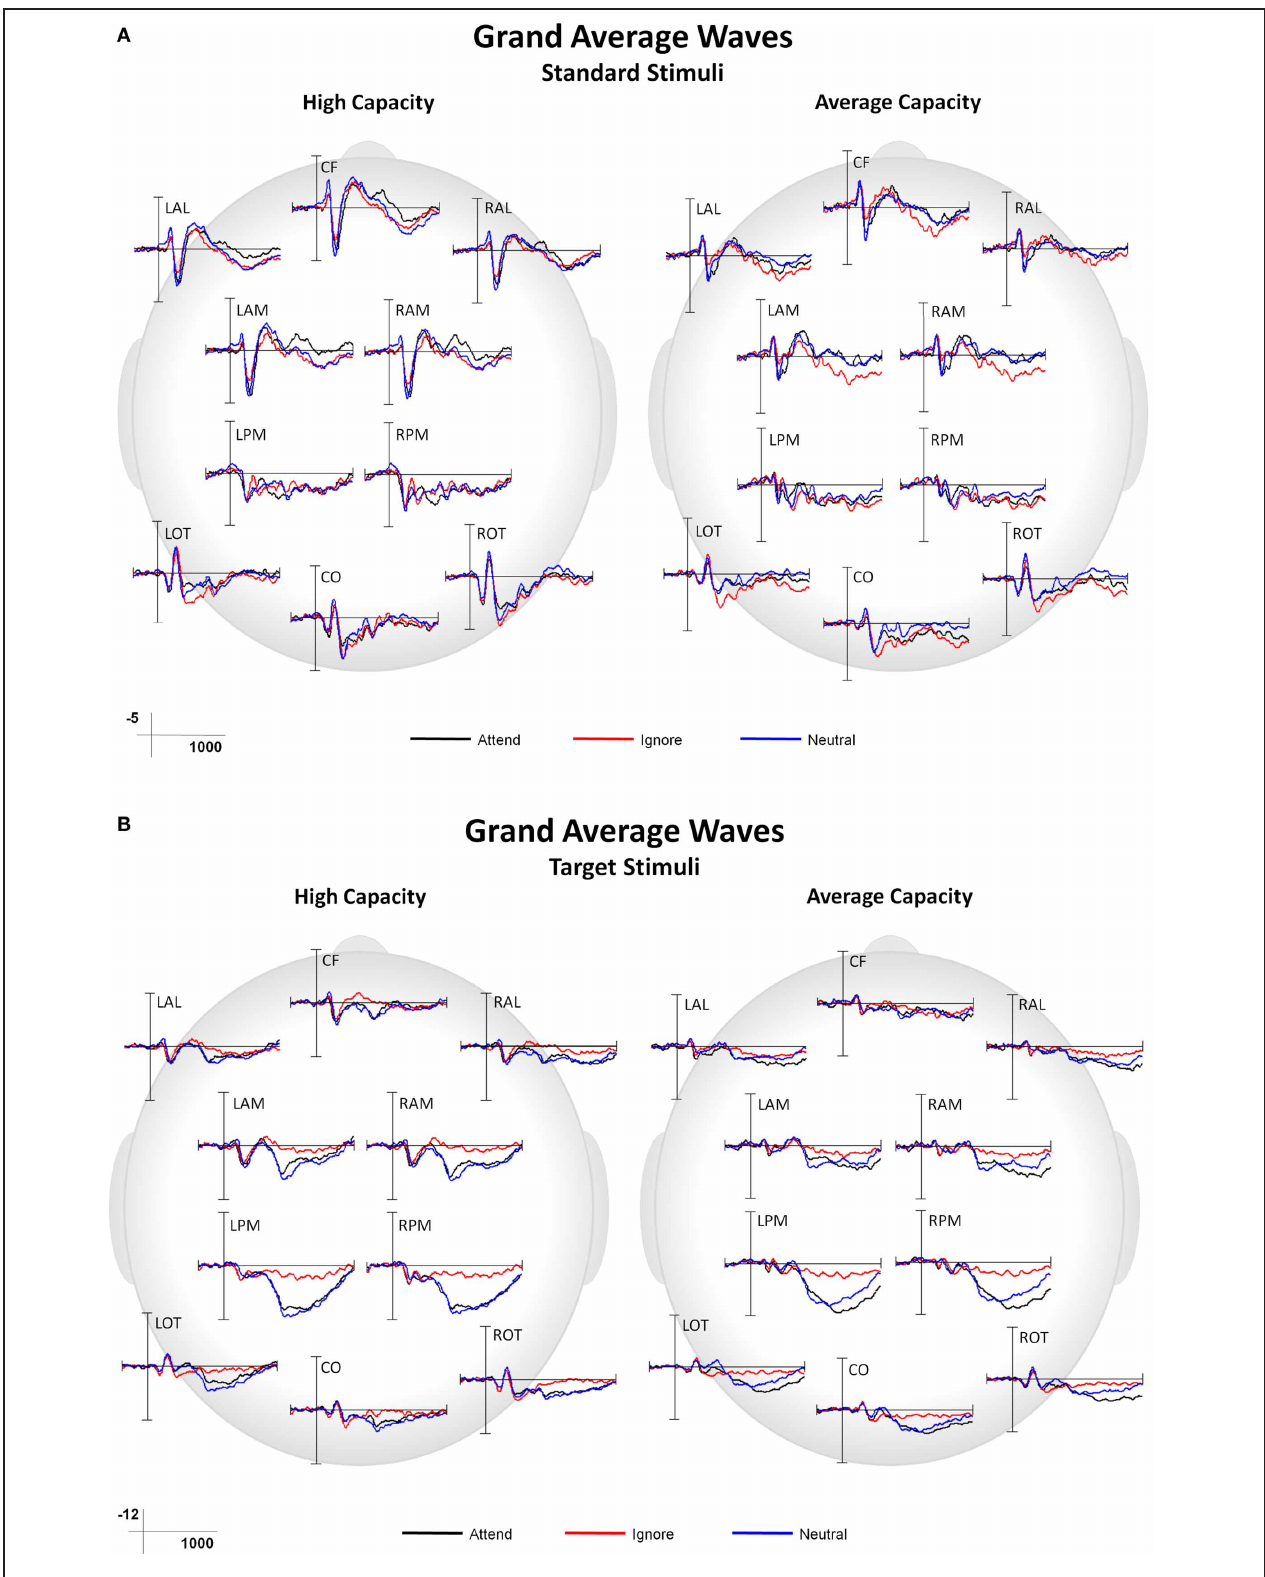
FIGURE 3 | Grand average ERP responses under Attend, Ignore, and Neutral conditions at all 10 ROIs for high capacity and average capacity subjects in response to (A) standard stimuli and (B) target stimuli.